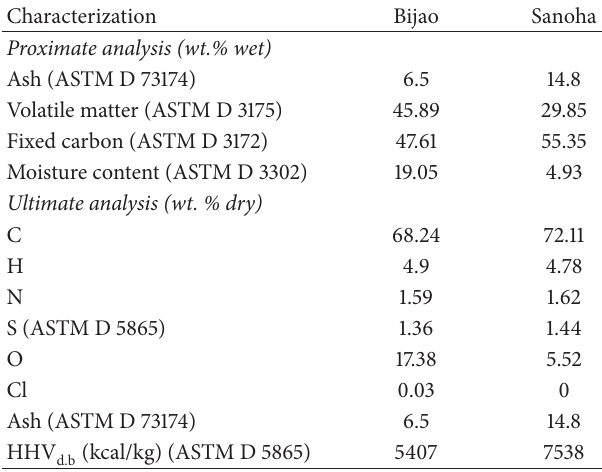
Table 1: Chemical characterization of Colombian coals (Bijao coal and Sanoha coal) used in